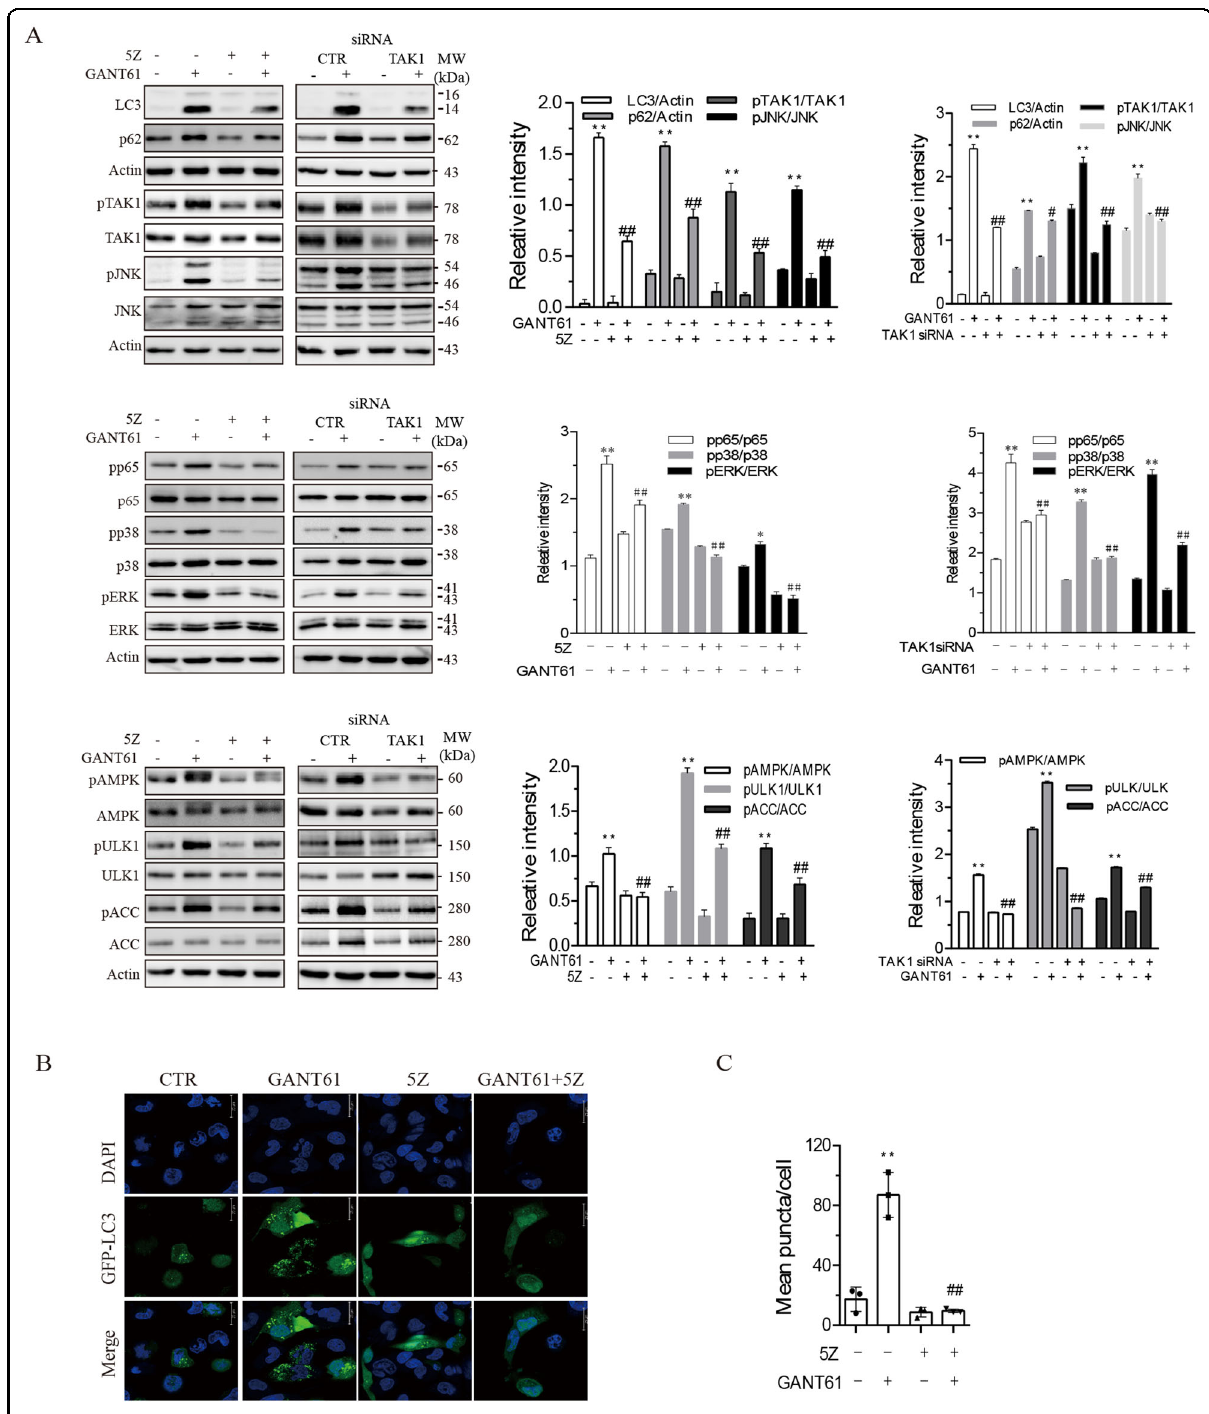
Fig. 3 TAK1 mediates GANT61-induced autophagy. A SW1736 cells were incubated in the absence or presence of GANT61 (10 μ M) minus or plus 5Z (1 μ M) for 48h. Alternatively, SW1736 cells were transfected with scrambled or TAK1 siRNA (2.5 nmole each). After incubation for 4h, the cells were left untreated or treated with GANT61 (10 μ M) for 48h. Cell lysates were prepared and analyzed for total and phosphorylated proteins by western blot. The expression levels were analyzed by quanti fi cation of the density of the protein bands with NIH Image-J software and presented as bar graphs. * p <0.05; ** p <0.01, compared to the untreated control; # p <0.05; ## p <0.01, compared to GANT61-treated SW1736 cells. B , C Inhibition of GANT61-induced autolysosome formation by 5Z. SW1736 cells transiently transfected with the expression vector encoding the GFP-LC3 gene were incubated in the absence or presence of GANT61 (10 μ M) minus or plus 5Z (1 μ M) for 48h. After nuclear staining with DAPI, the cells were examined under a confocal microscope for the presence of autophagosomes ( B ). The number of autophagosome puncta per cells was statistically analyzed ( C ). Bar length: 20 μ m. **p <0.01, compared to untreated control; ##p <0.01, compared to